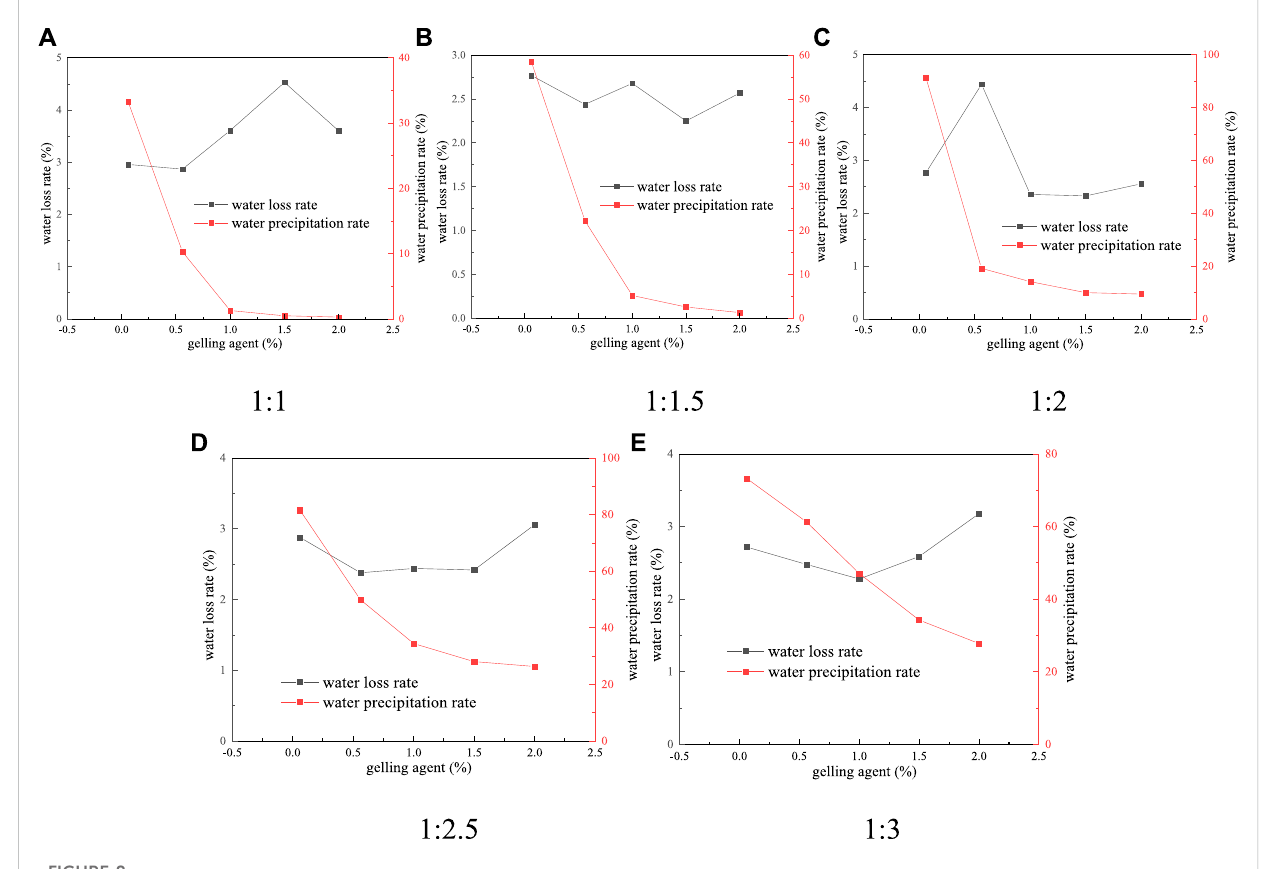
FIGURE 8 (A-E) represent concentration ratios of fl y ash and water of 1:1, 1:1.5, 1:2, 1:2.5 and 1:3, respectively.